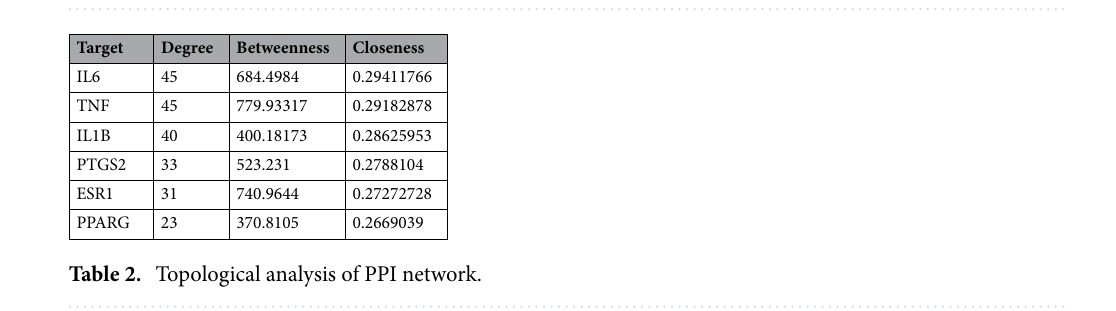
Figure 5. PPI network performed by STRING database. Contains 79 nodes with 449 edges. The average node degree is 11.4, avg. local clustering coefficient is 0.688, and PPI enrichment P -value < 1.0e−16.